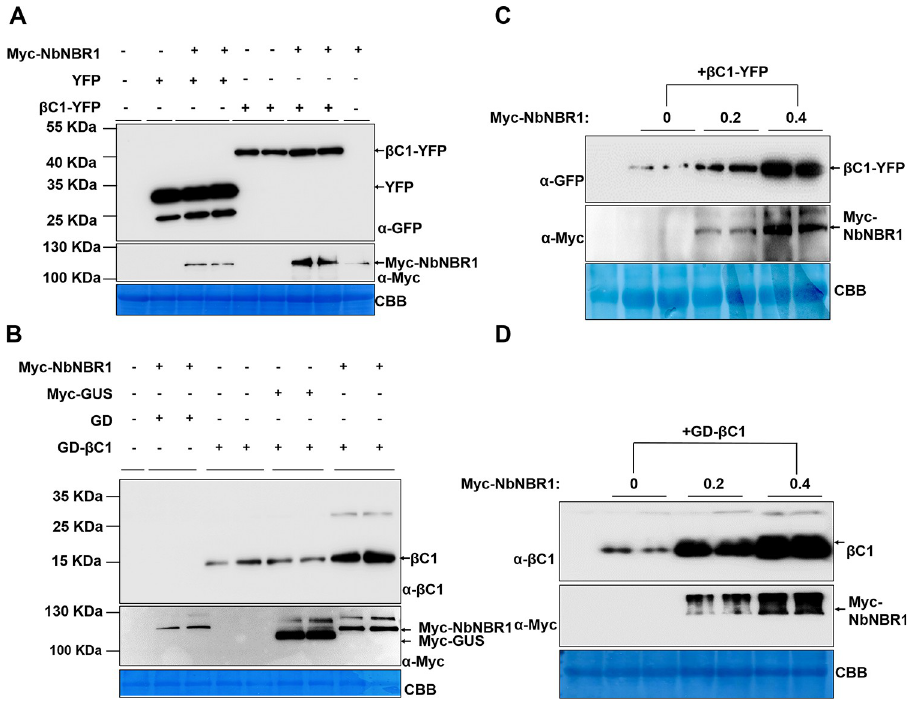
Fig 3. Co-expression of Myc-NbNBR1 increases β C1 accumulation. (A) Myc-NbNBR1, YFP, and β C1-YFP were transiently co-expressed, as indicated, in N . benthamiana leaves followed by Western blot assays using anti-GFP or anti-Myc antibodies. (B) Myc-NbNBR1, Myc-GUS, GD, and GD- β C1 were transiently co-expressed, as indicated, followed by Western blot assays. (C) Agrobacterium tumefaciens culture carrying Myc-NbNBR1 (OD 600 = 0, 0.2 or 0.4) was mixed with A . tumefaciens cultures carrying β C1-YFP, and then infiltrated into N . benthamiana leaves followed by Western blot assays. (D) A . tumefaciens culture carrying Myc-NbNBR1 (OD 600 = 0, 0.2 or 0.4) was mixed with A . tumefaciens cultures carrying GD- β C1, and then infiltrated into N . benthamiana leaves followed by Western blot assays. The CBB-stained Rubisco large subunit gels were used to show equal sample loadings (A-D). Each experiment was repeated three times with similar results. Arrows indicate the corresponding protein bands as